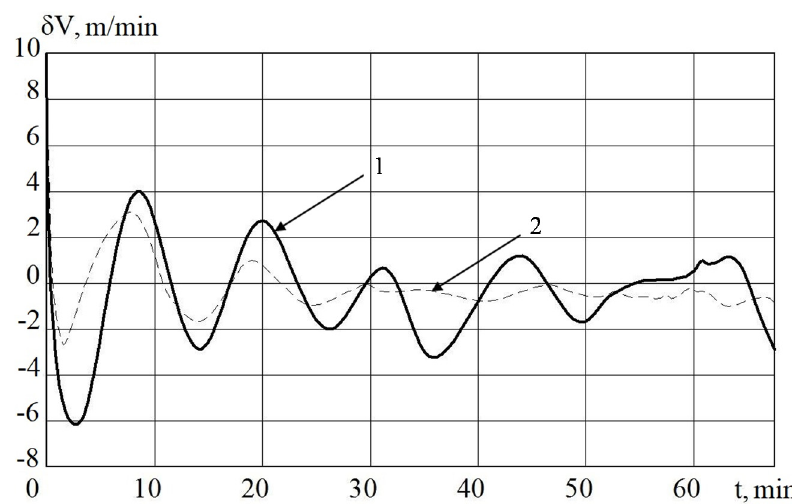
Figure 4. INS errors in determining the velocity MC with regulator (1) and non-linear SDC regulator (2).